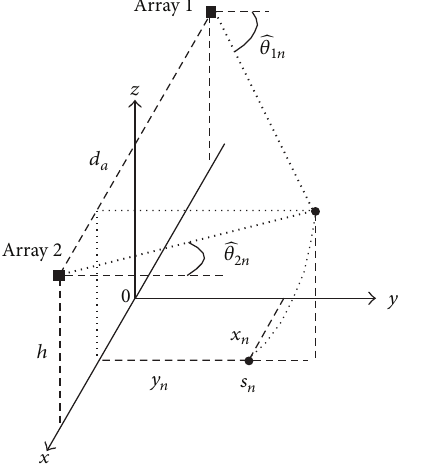
Figure 6: The two-dimensional position of the source of the experimental prototype.